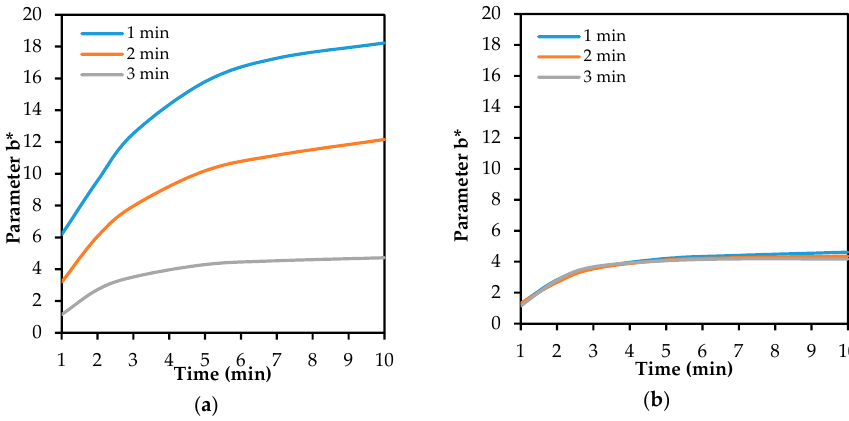
Figure 7. The influence of the incubation period on the inhibition of BuChE by physostigmine (10 µg/mL), and therefore on the discolouration of the detection fabric (carriers with BuTChI): ( a ) filter glass paper; ( b ) filter cellulose paper.